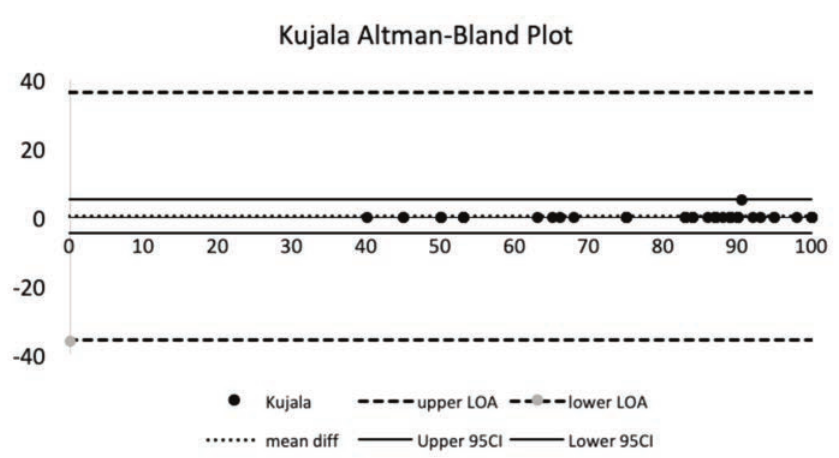
The Altman-Bland plot showed that 95% CI was still in the range of the limits of agreement and showed no Fig. 2: